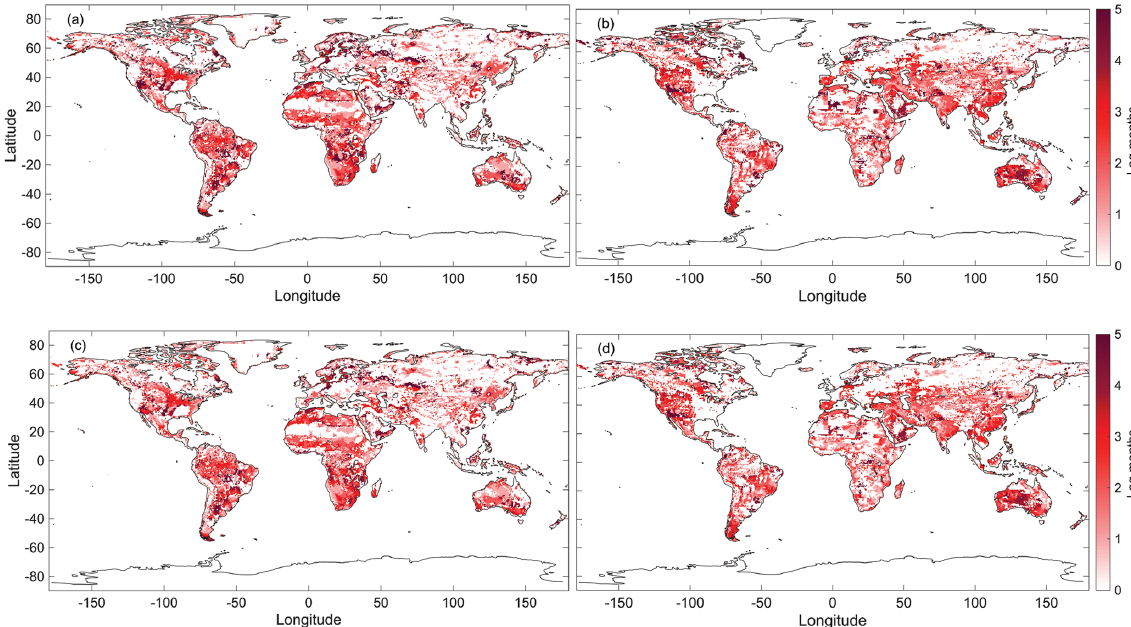
Figure 4. Maps display the number of months between the SWAMPS, GRACE, and GPCP signal that were statistically determined by cross-correlations. (a) GPCP lag map with a time threshold of 0 to 11 months. (b) GRACE lag map with a time threshold of 0 to 11 months. (c) GPCP lag map with a time threshold of 0 to 5 months. (d) GRACE lag map with a time threshold of 0 to 5